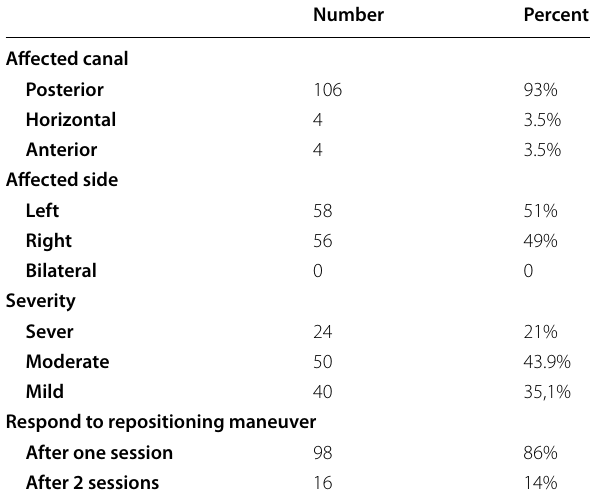
Table 3 The feature of BPPV and management outcome in 114 patients